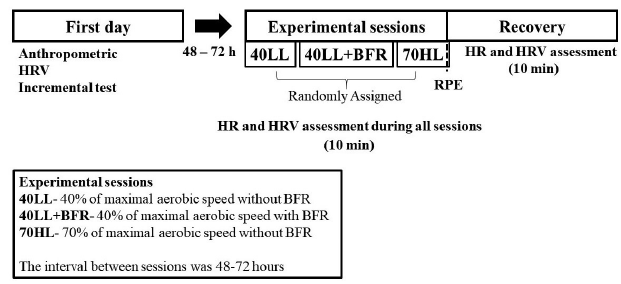
Figure 1. Schematic representation of the experimental